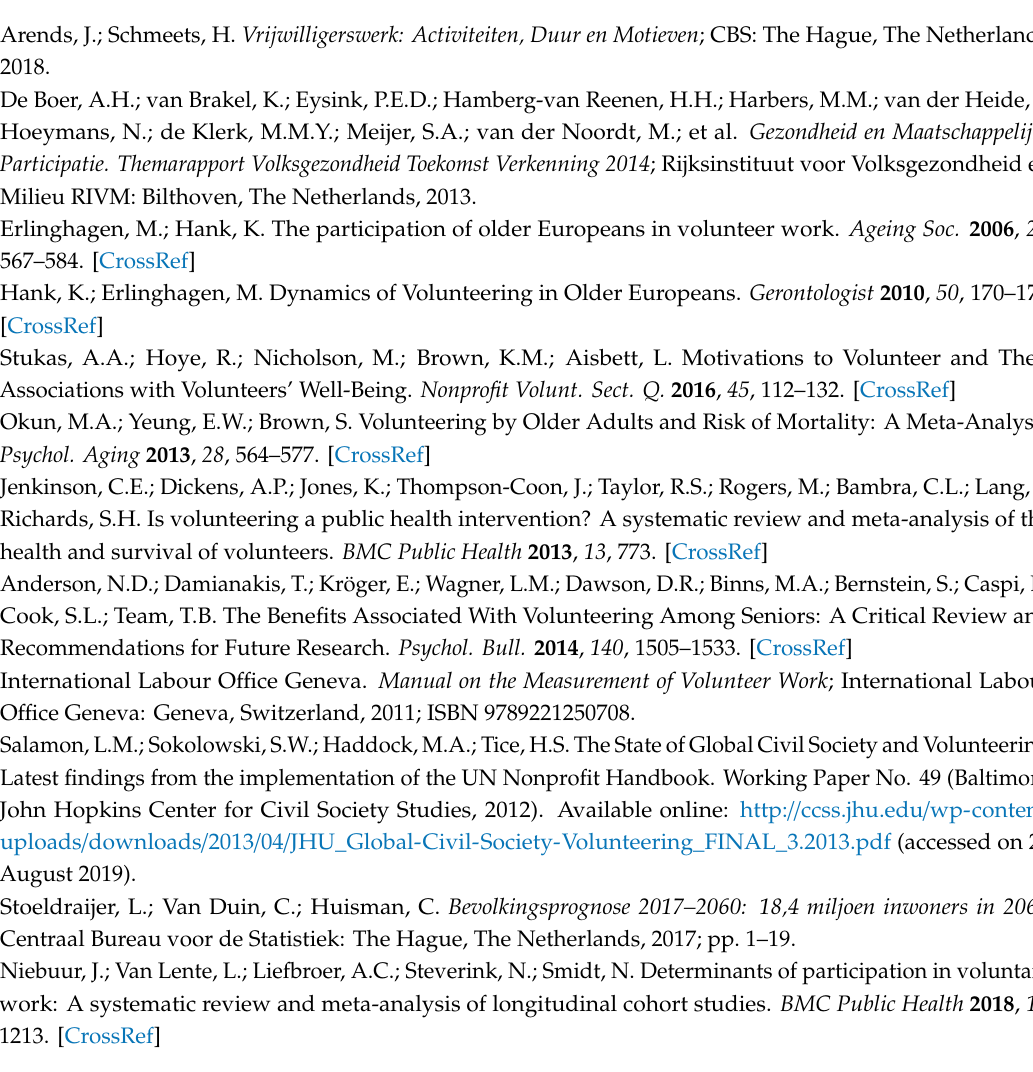
Table S1: Dutch translation of the VFI; Table S2: Sensitivity Analysis comparing CFA factor loadings from ML and ADF